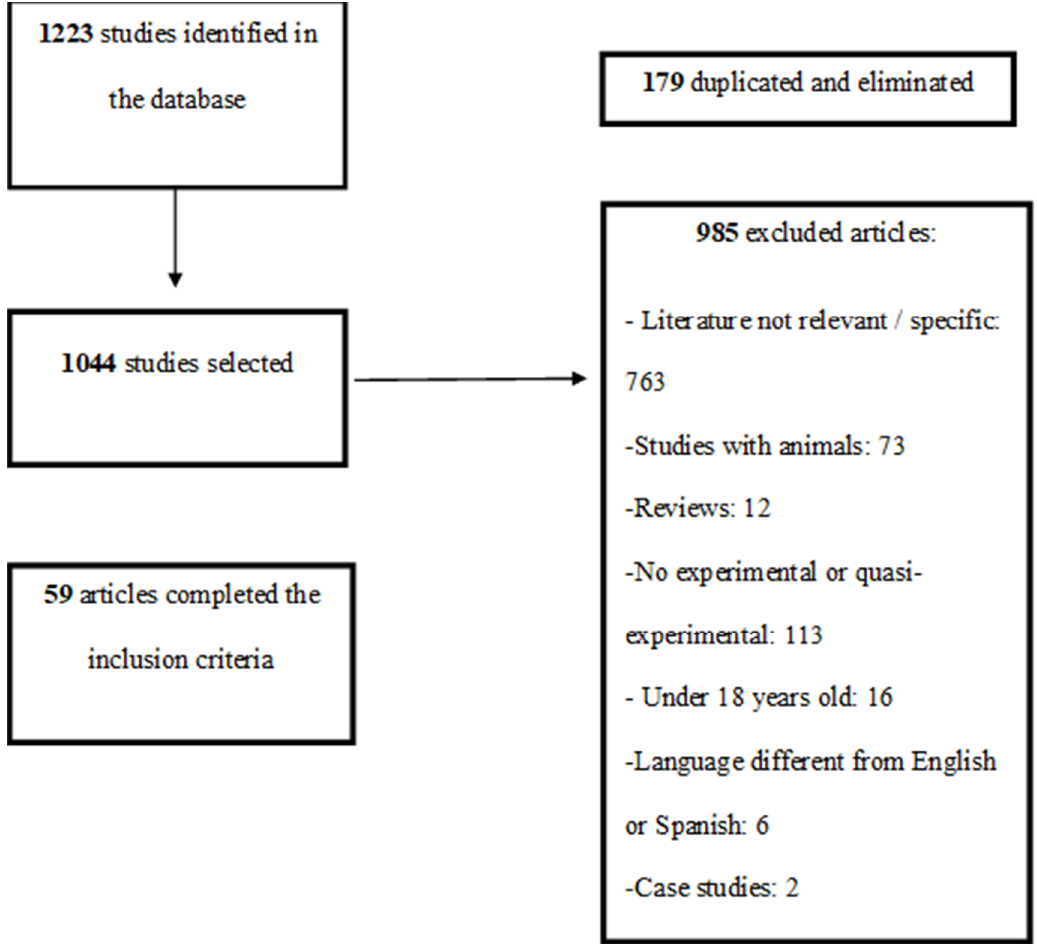
Figure 1. Flowchart of the study selection process.